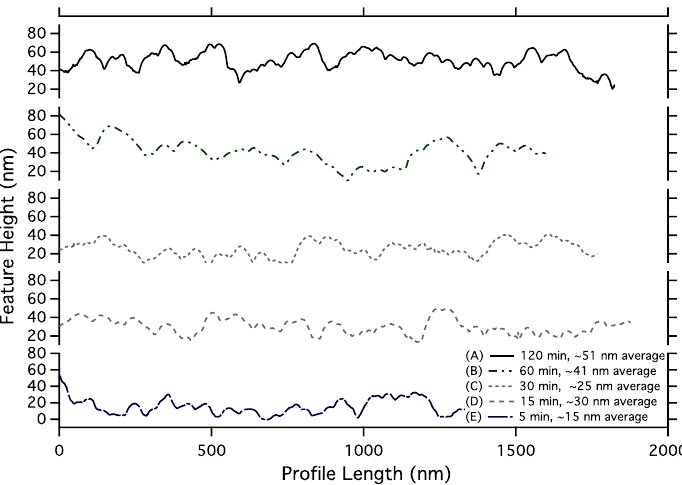
Figure 4. Vertical line profiles taken from AFM scans as in Figure 3: (A) 120 min; (B) 60 min; (C) 30 min; (D) 15 min; and (E) 5 min. The full scales of the feature height axis are 80 nm for all five profiles, showing the increase in height as coating time increases.